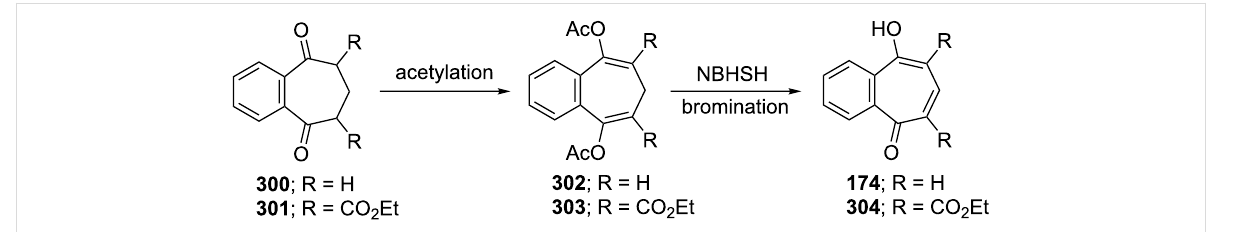
Scheme 49: Reaction of 7-hydroxy-2,3-benzotropone ( 241 ) with various reagents.